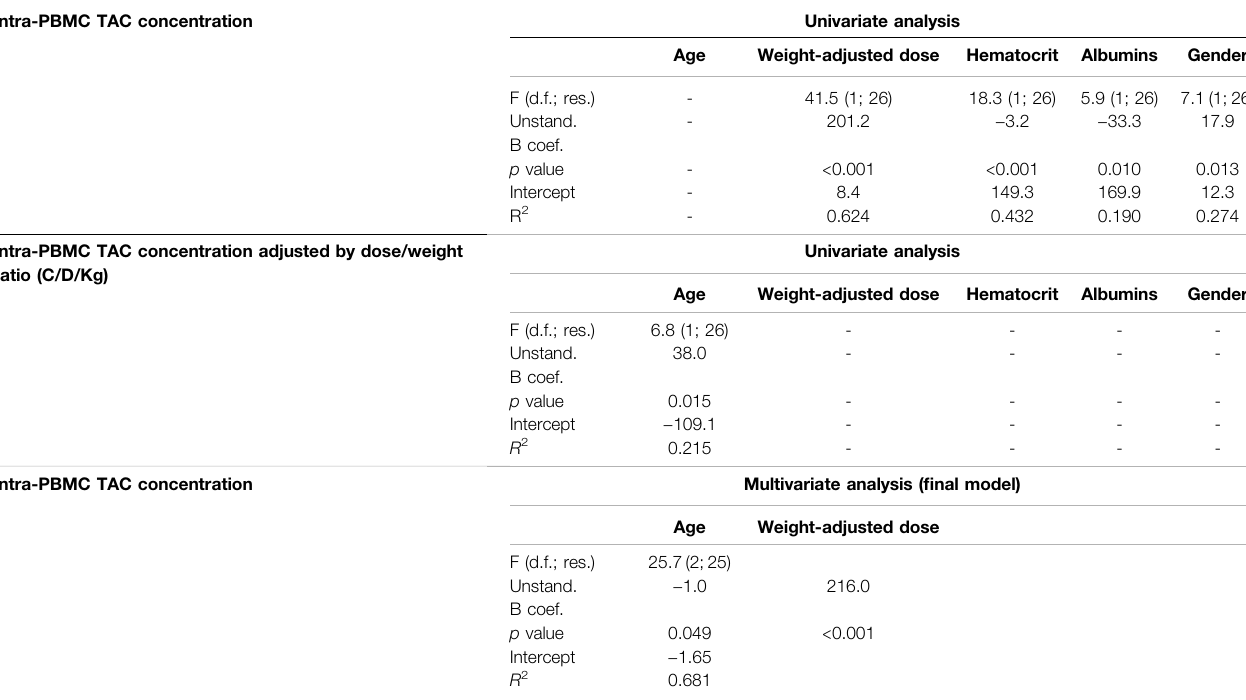
TABLE4| Reportoftheunivariateandmultivariate regressionanalysisforthepredictionofTACconcentrationsinPBMC.AllthestatisticshavebeenreportedinAPAformat. Intra-PBMC TAC